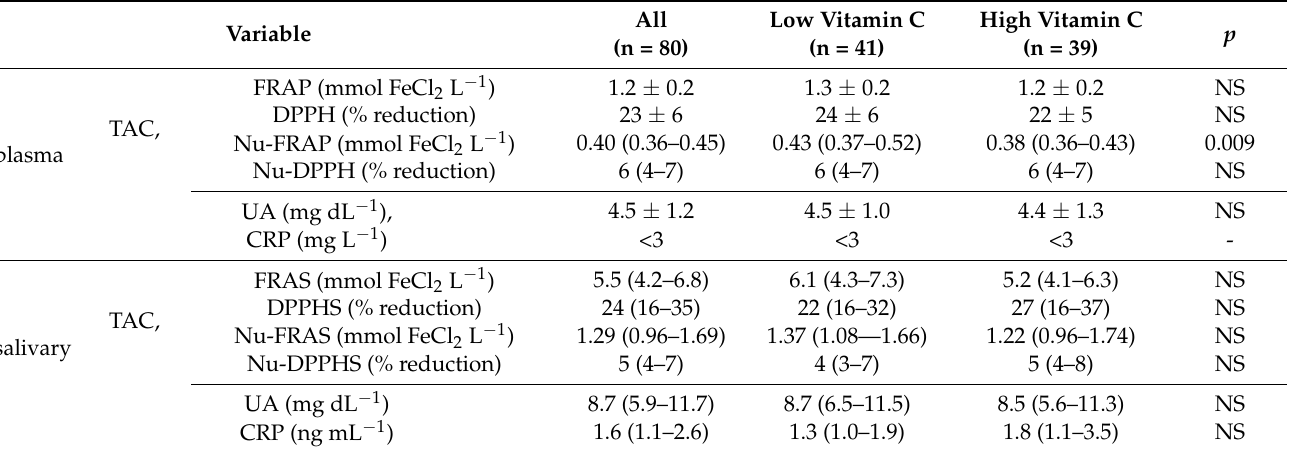
Table 3. Plasma and salivary non-urate and native antioxidant indices, and C-reactive protein for the groups with high and low Vitamin C